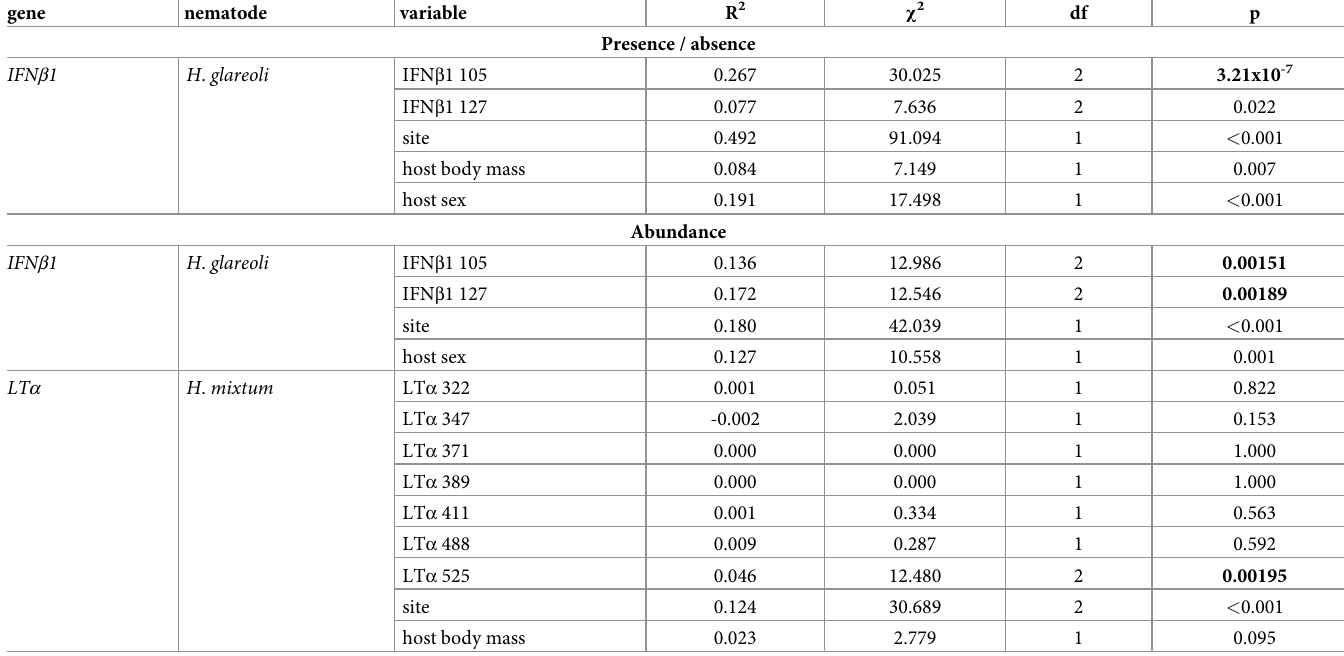
Table 2. Summary of GLM models showing significant effect of SNP genotype at given locus on the parasite load. Table presents summary of GLM models including non-genetic terms as indicated in S4 Table. All models are given in S6 Table. R 2 is partial coefficient of determination (effect size), χ 2 and p-values are based on LR type III test. To control for multiple comparisons when testing for the effect of several genetic variants, we used conservative Bonferroni correction. For 10 genetic terms (SNPs) tested, the critical p-level corresponding to α = 0.05 is 0.005. p-values of genetic terms significant after correction are given in